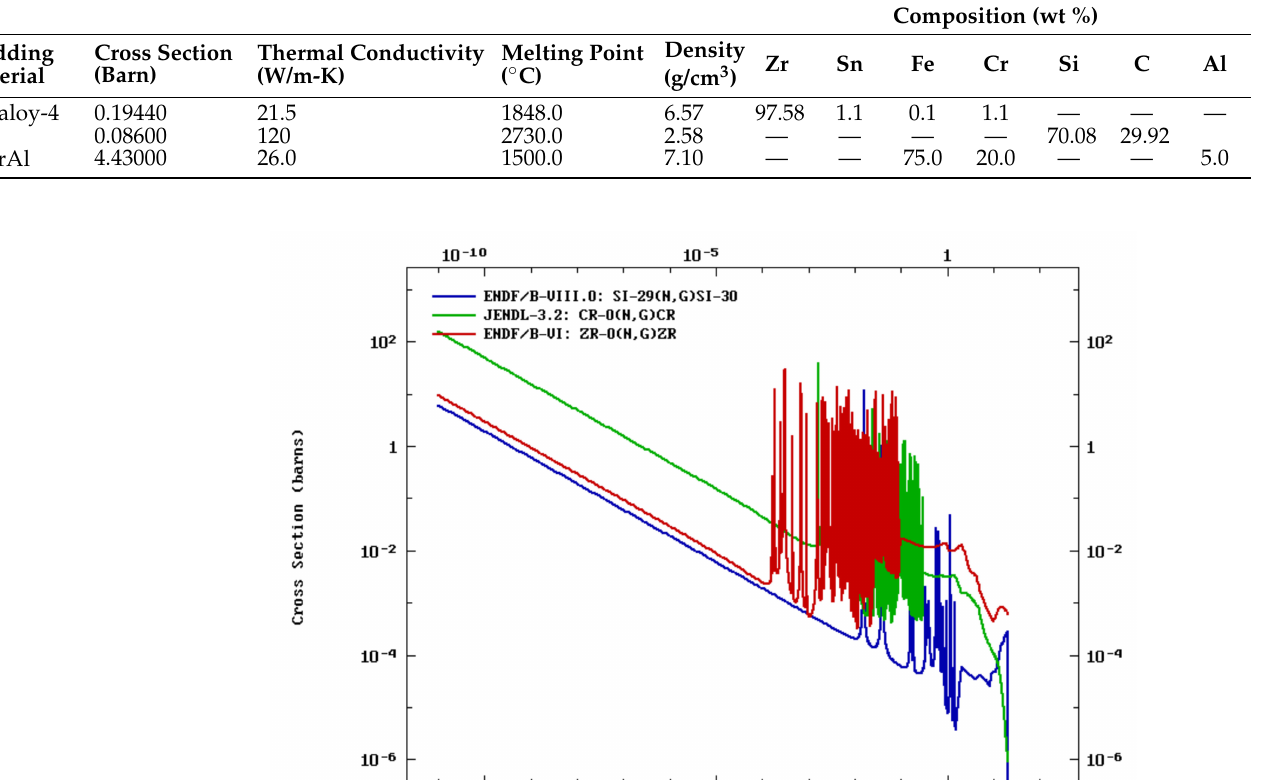
Table 2. Composition of cladding materials [2,29–31].